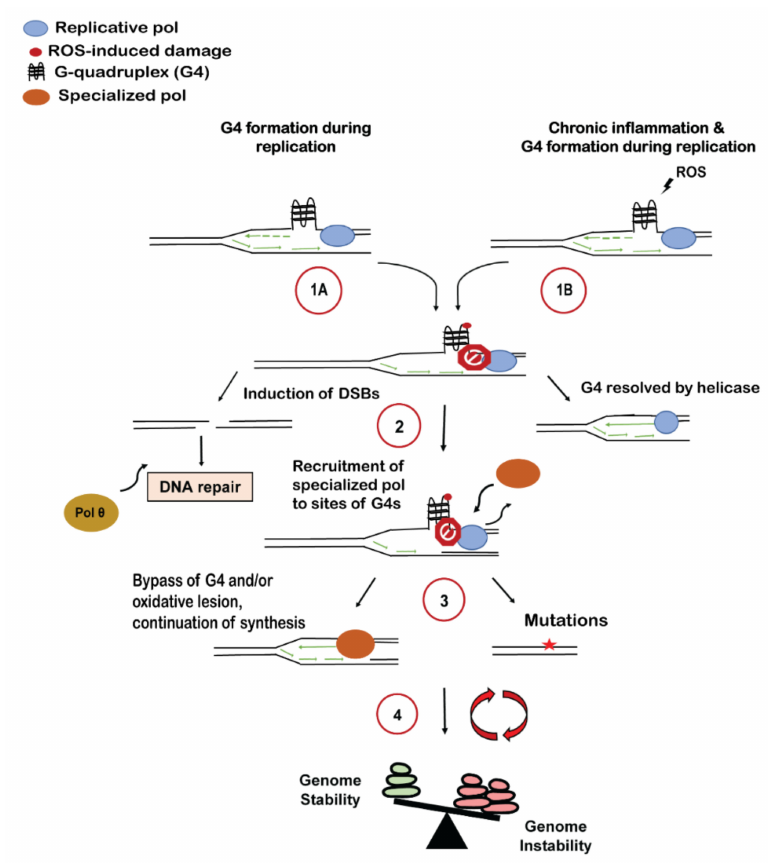
Figure 1. Consequences of G4s on DNA Replication within the Context of Chronic